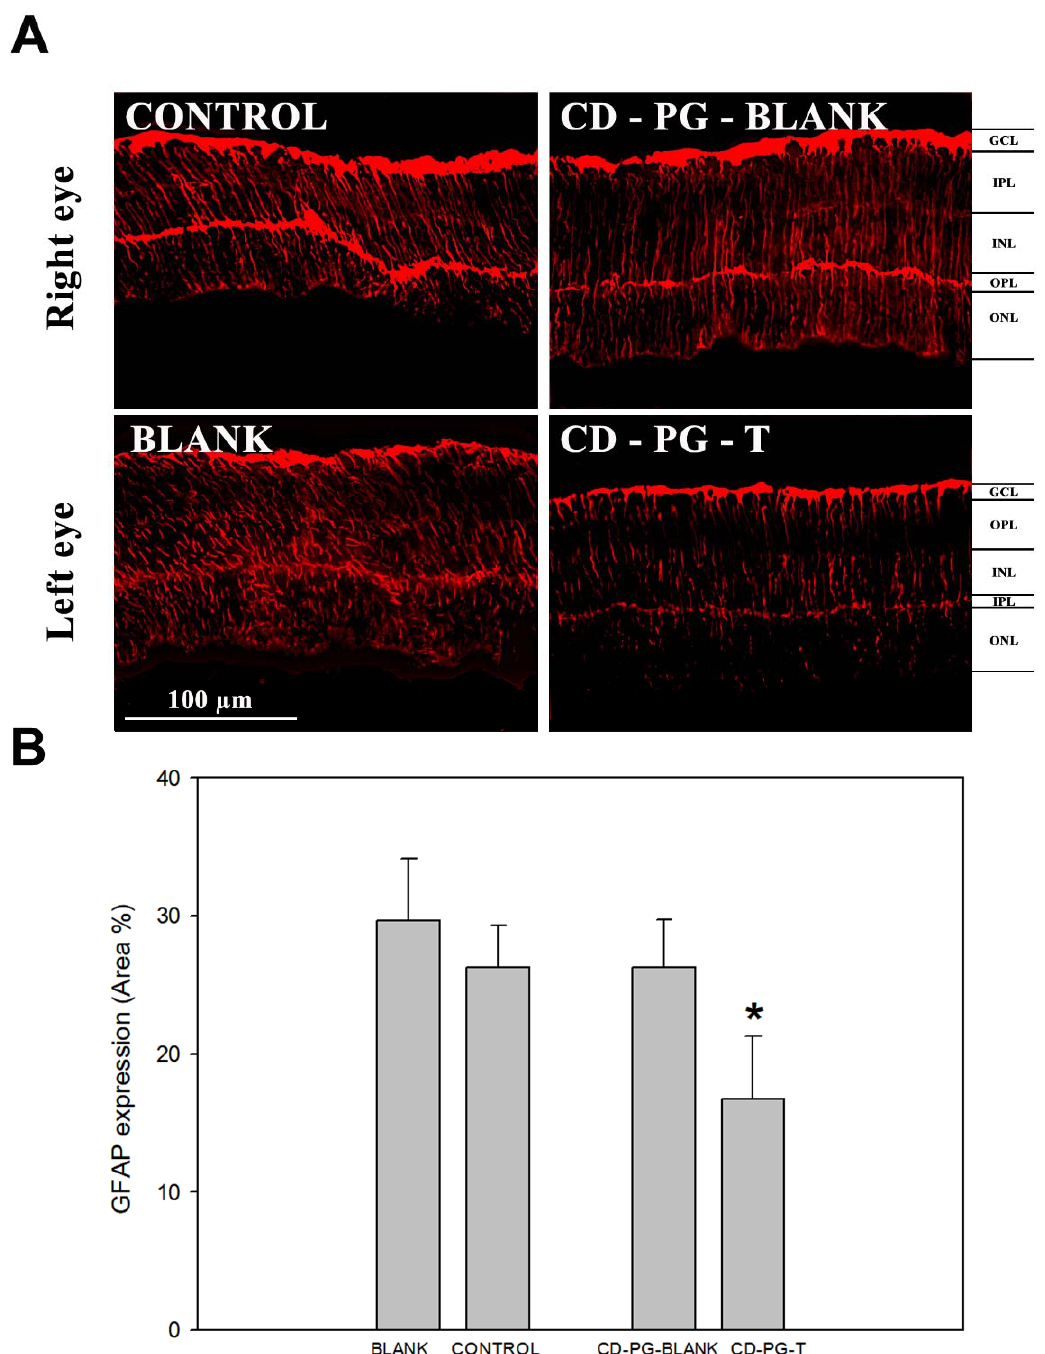
Figure 3. GFAP immunofluorescence. ( A ) An example of GFAP staining for each experimental group. ( B ) Results of GFAP quantification. * Statistically significant difference ( p -value < 0.05) of CD-PG-T vs. control, blank, and CD-PG-blank.